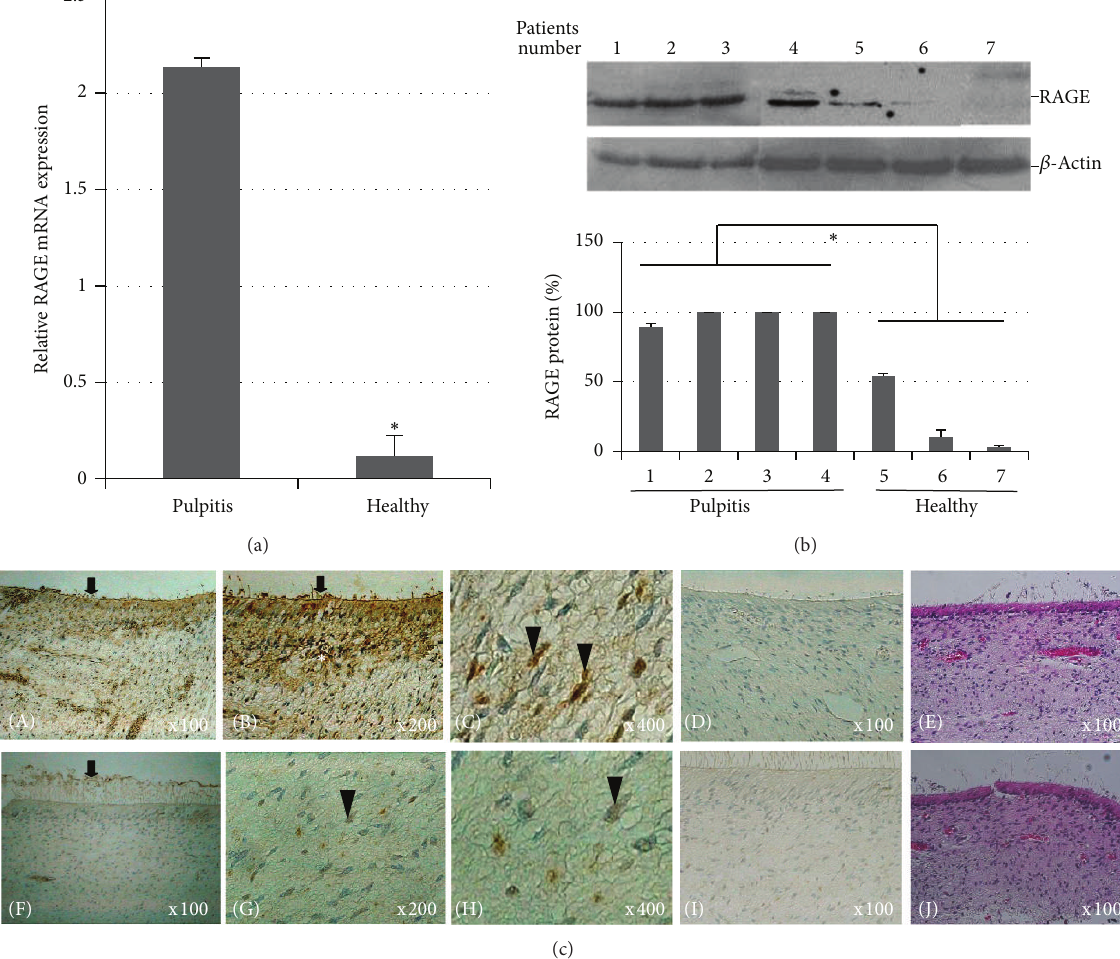
Figure 1: Upregulated expression of RAGE in human pulp tissue from teeth with a clinical diagnosis of irreversible pulpitis. (a) The expression of RAGE in inflamed human and healthy tissue was examined by quantitative real-time PCR. Total RNA was extracted from a pool of three dental pulp tissues from either pulpitis or healthy samples. RAGE mRNA levels were quantified relative to levels of GAPDH. (b) RAGE protein in inflamed and healthy pulp tissues was examined by western blot analysis. Representative blots using antibodies against RAGE and 𝛽 -actin from four pulpitis and three healthy pulp tissues are shown. RAGE expression was quantified by densitometry and normalized to 𝛽 -actin. Results are expressed as the means ± SD from three independent experiments. ∗ 𝑃 < 0.001 . (c) Immunochemical staining of RAGE in pulp tissue sections. Black arrows indicate odontoblast processes in tubules of predentin. Higher magnification of stromal pulp fibroblasts-like cells is indicated by arrowhead. RAGE expression in infiltrating inflammatory cells ( ∗ ). The IgG isotype control was employed at the same time and concentration (D and I) as the test antibody. Counterstaining was performed with Mayer’s hematoxylin (E and J).